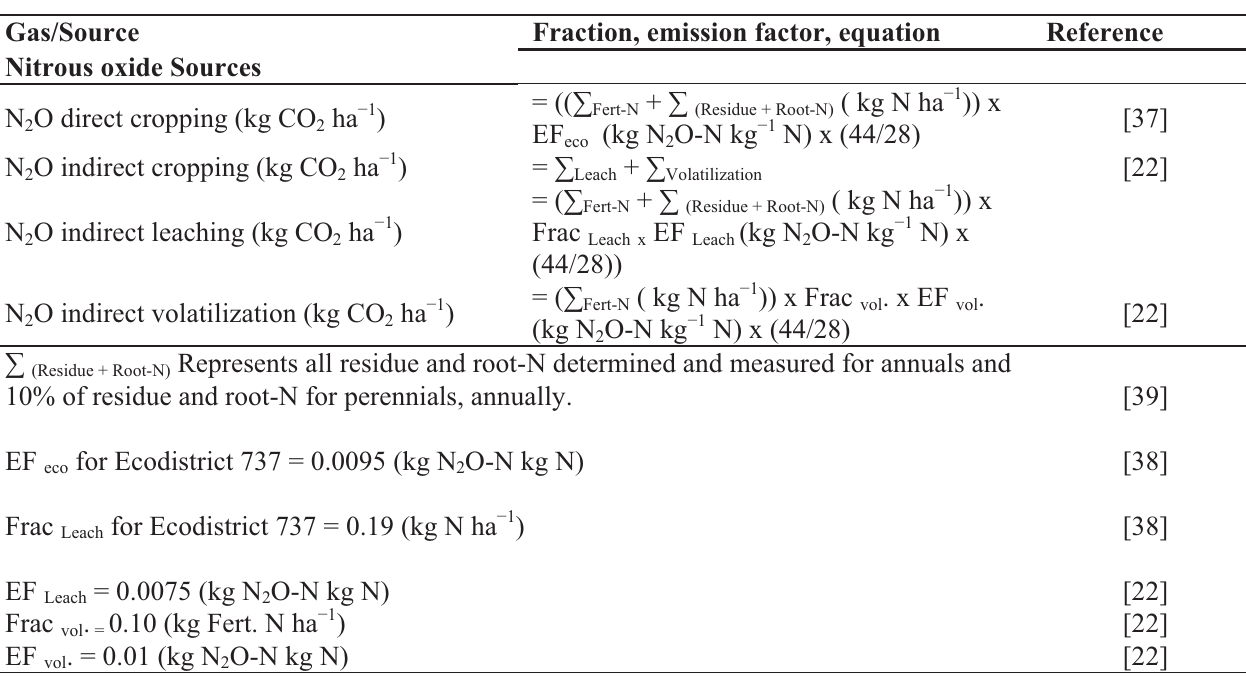
Table A5. Sources of cropping related direct and indirect nitrous oxide emissions for each crop and pasture.